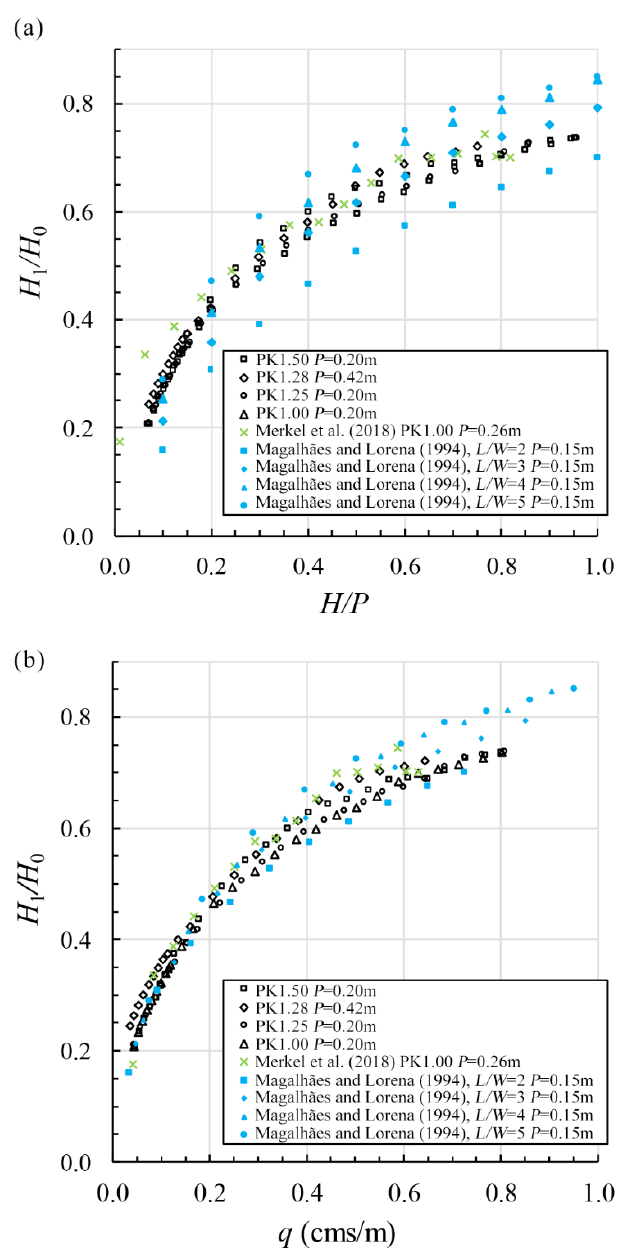
Figure 8. Relative residual energy ( H 1 / H 0 ) with respect to ( a ) the head water ratio ( H / P ) and ( b ) unit discharge ( q ) for Type A PK weirs.